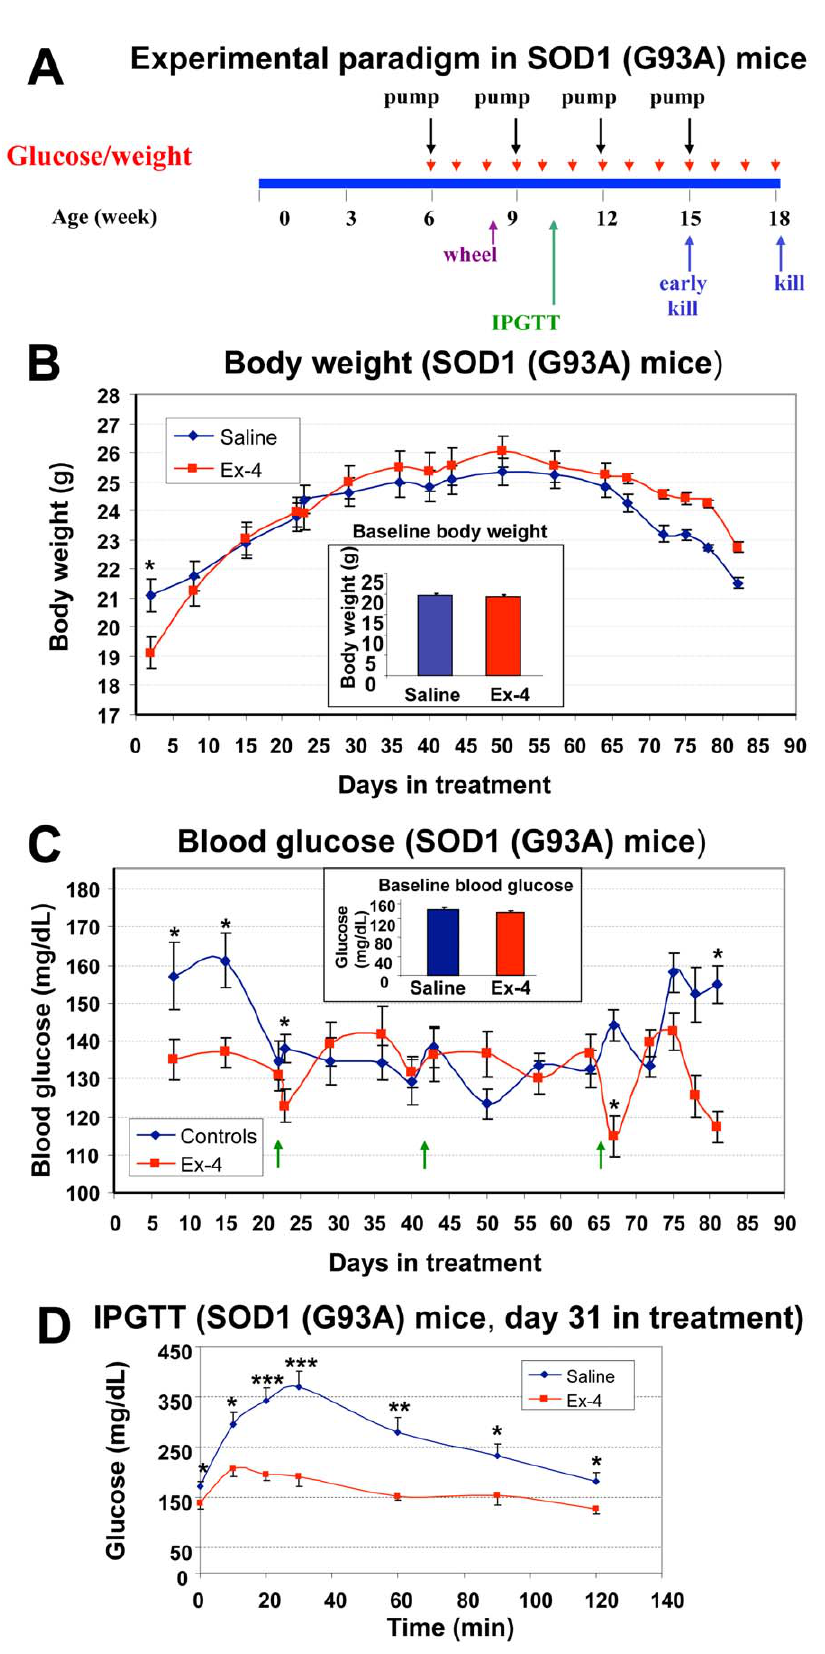
Figure 4. Design of animal study and gluco-regulatory effects of Ex-4 in SOD1 (G93A) mice. ( A ) Scheme of animal study: SOD1 (G93A) mice were assigned to two groups (n=15 mice/group), starting at the age of 6 weeks, saline or Ex-4 was delivered via subcutaneously implanted osmotic pumps in the control group and Ex-4 treatment group, respectively, throughout the study (treatment duration 12 weeks, hence mice were PLoS ONE |